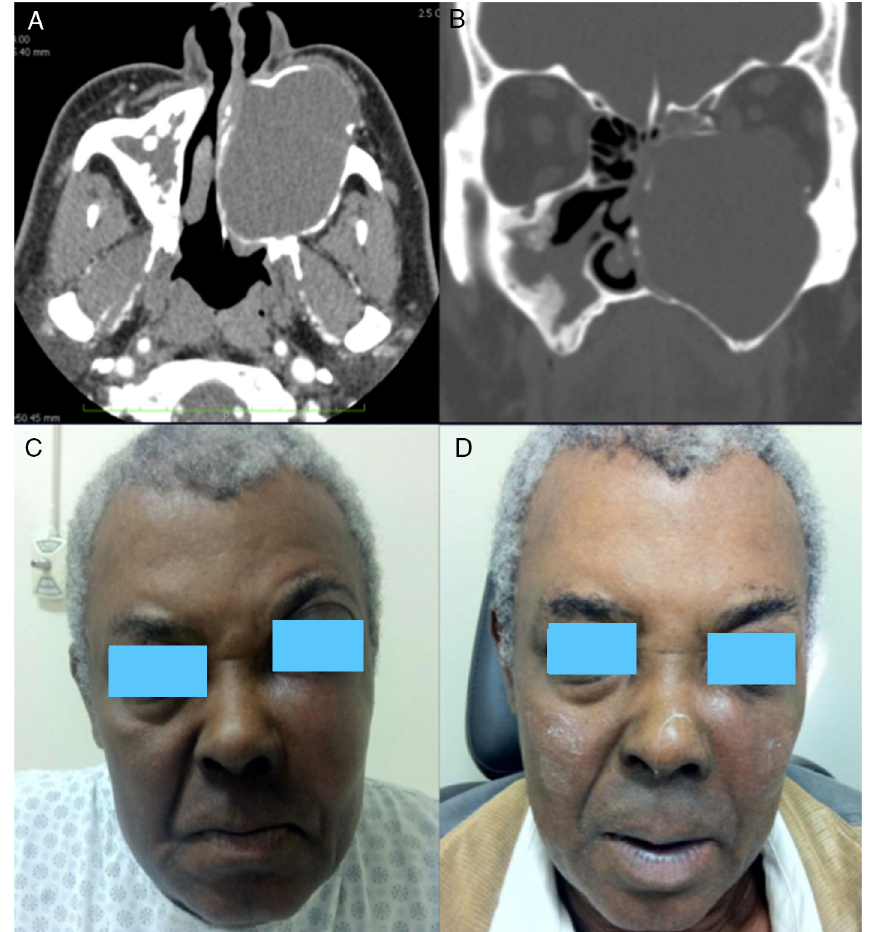
Figure 1 (A) Computed tomography (CT) (axial section), showing an expansive lesion occupying the entire left maxillary sinus and promoting remodeling of bone limits. (B) CT (coronal section), showing an extension of the lesion to the orbital cone. (C) Preoperative picture showing bulging of the malar area and proptosis (left side). (D) Postoperative photography showing a clear improvement of bulging and